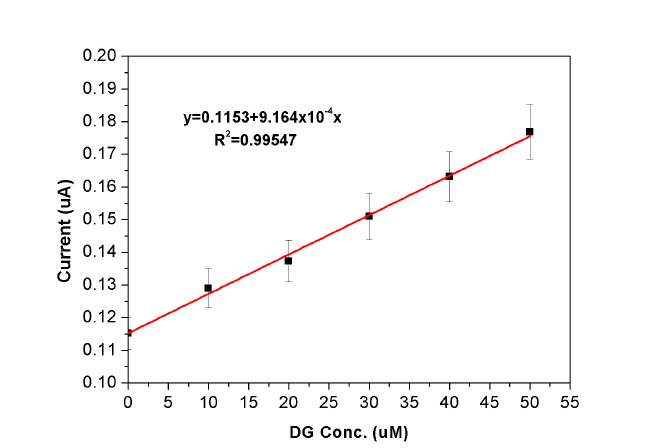
Figure 10. Calibration curve obtained at 300 s for the DG measurement in the 0.1 M pH 8.3 phosphate